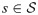
Series of sketches illustrating the components of the cellular scale persistent random walk.(A) An example of the orientation landscape, l, configurations for a hexagonal lattice. 1. All fibrils are aligned in the upward-right direction; this would be an example of a strongly aligned part of the ECM. 2. Half of the fibrils are aligned to the right, half in the upward-right direction. This would correspond to a branching point. 3. As in 2. but with some additional fibrils aligned in the left direction. (B) The window function, Ws(ϕ), (Eq (15)) has been defined as an indicator function over an angle interval corresponding to each possible migration direction s∈S (lattice-dependent). The diagram illustrates these intervals for a hexagonal lattice. (C) Illustration of the probability distribution function of the von Mises distribution, fvM(x|μ, κ), centred at μ = 0 for different fixed κ (Eq (12)). (D) Illustration of the κ function as a function of local Delta ligand level, Di, and concentration of BM components, mi, (Eq (14) with K = 13.6, km = 2.2 and kD = 0.0002). (E) An example of the neighbourhood function, F(EiN) (Eq (9), with EF1 = 0.15, EF2 = 0.6, sF1 = 30, sF2 = 10). (F) A sketch showing how the switching probability, pswitch(Di), changes with the level of Delta in voxel vi, Di (Eq (10) with pmax = 0.26, sp = 0.0015, Dp = 1500).